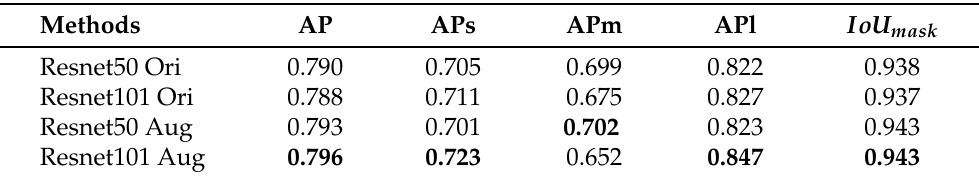
Table 2. AP segment performance.